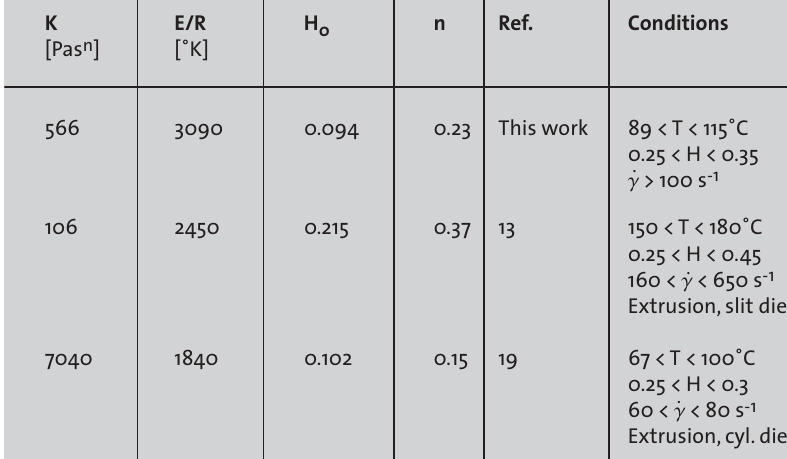
Figure 7 (left): Specific energy for plastification in the capillary rheometer for the 30 ( (cid:2) ) and 35% (O) water content samples. The specific energy was calculated from the Poiseuille flow. Table 2 (right): Values of the parameters of Eq. 5 from the literature and this work for maize